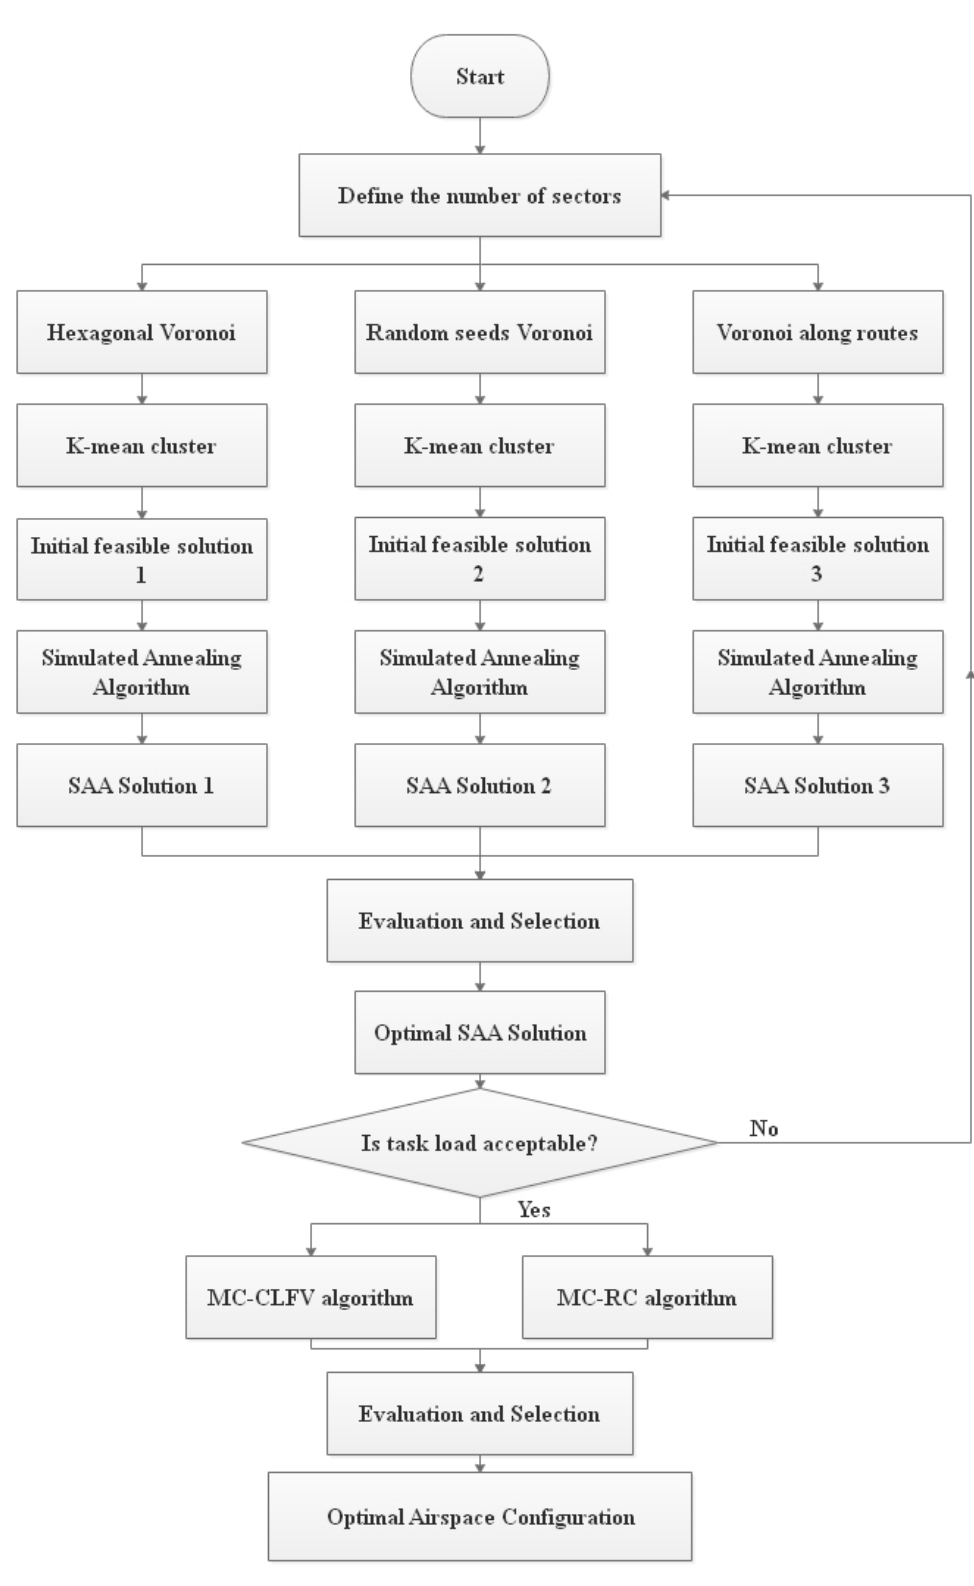
Figure 9. Framework of the solution method.